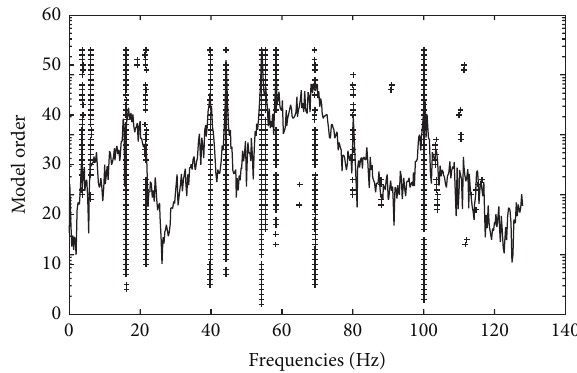
Figure 6: The stabilization diagram with the new stabilization